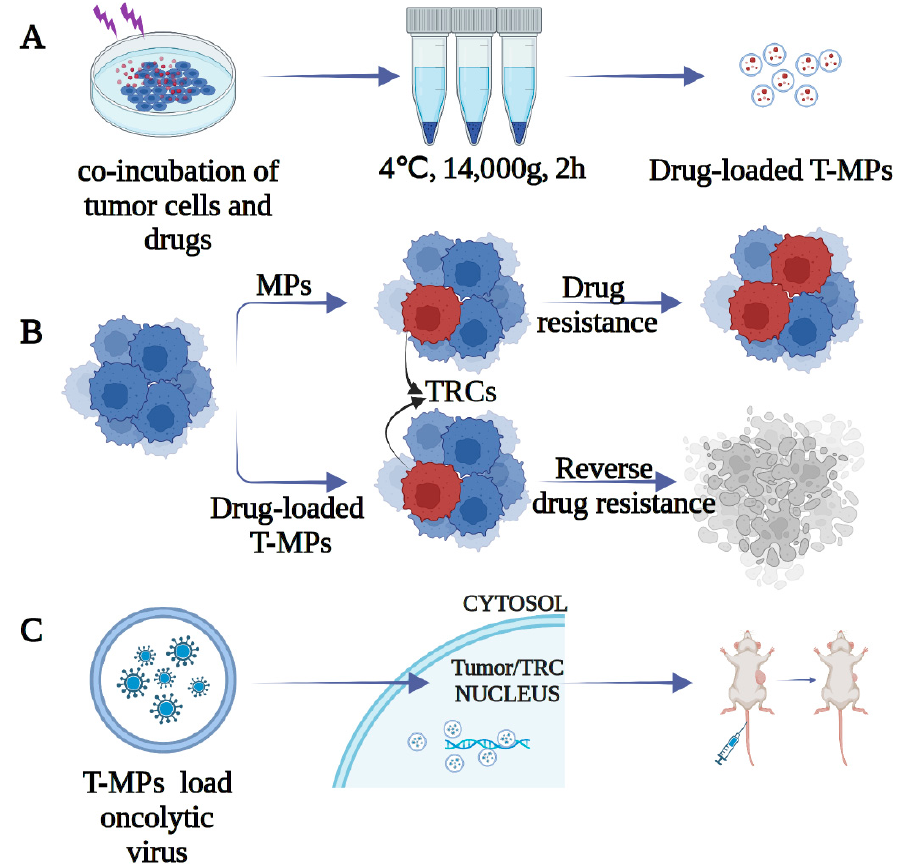
Figure 1. MP potential for delivering chemotherapy drugs and other cargos. ( A ) Chemotherapy- loaded T-MPs [18] (Nature Communication, 2012); ( B ) drug-loaded T-MPs reverse TRC drug resistance [50] (Cell Research, 2016); ( C ) T-MPs carry oncolytic viruses into the nuclei of tumor cells based on [56] (Cancer Immunology Research, 2015).